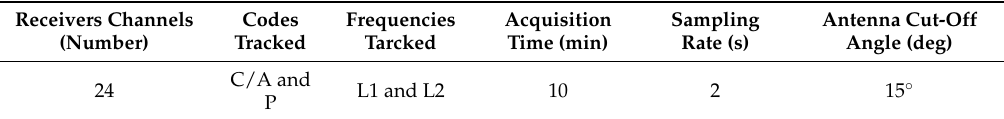
Table 1. Characteristics of the instruments and of the survey strategies.